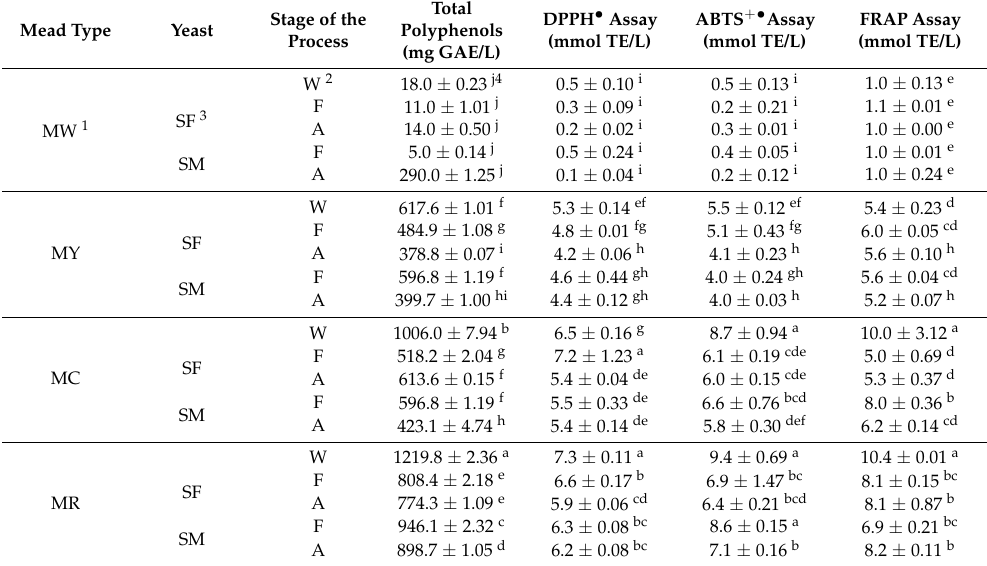
Table 2. Total polyphenols content and antioxidative activity of meads (MW, MY, MC, MR) at particular technological stages of their manufacture process: wort (W), meads after fermentation (F), meads after aging